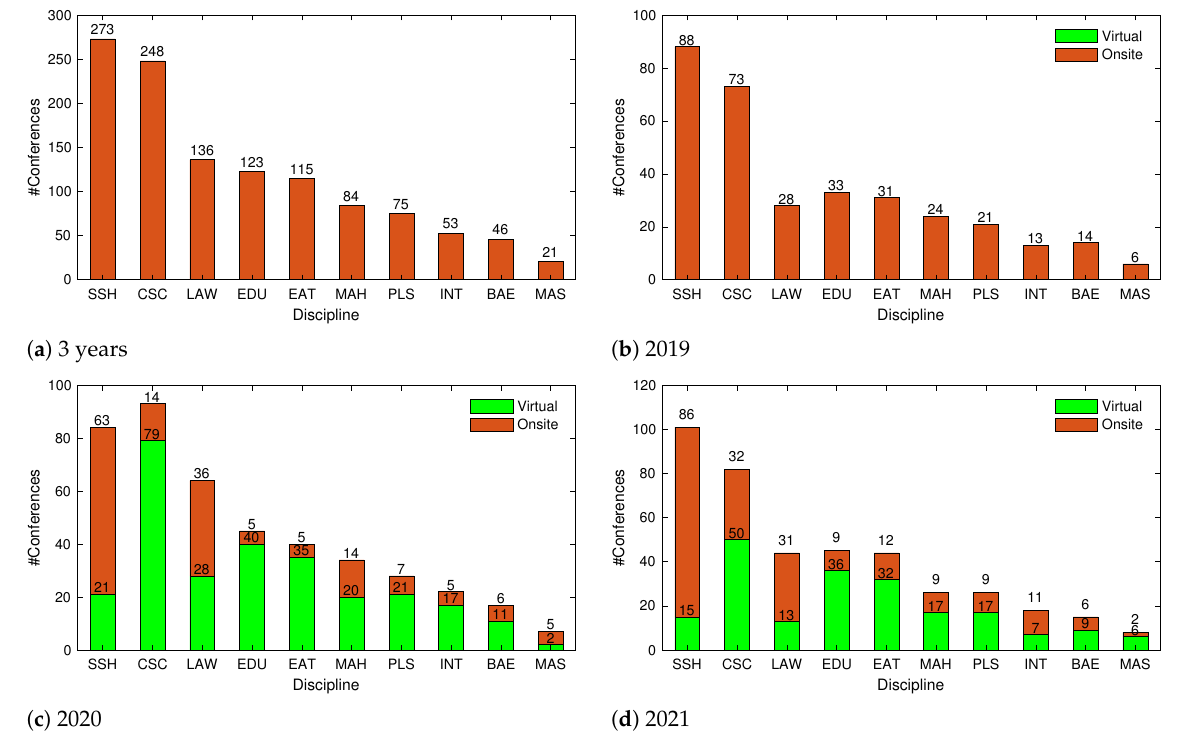
Figure A2. Number of conferences belonging to each discipline. ( a ) Ranking of the disciplines by the number of conferences they covered over the three years. ( b – d ) Number of virtual and onsite conferences covered by each discipline in 2019, 2020 and 2021, respectively.